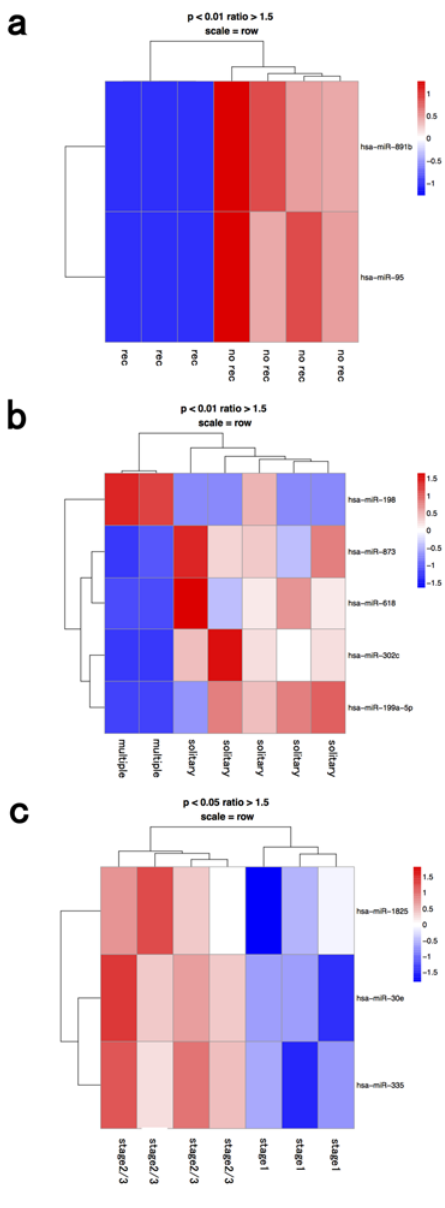
Figure 1. Hierarchical clustering analysis of microRNAs of whole bone marrow cells in seven patients with hepatocellular carcinoma. Heat map of the miRNA profile in bone marrow cells from hepatocellular carcinoma patients with ( a ) recurrence ( n = 3) and no recurrence ( n = 4); ( b ) solitary ( n = 5) and multiple tumors ( n = 2); ( c ) stage 1 ( n = 3) and ≥ stage 2 ( n = 4). Cluster analysis showed two, five, and three miRNAs that were significantly differentially expressed between the two groups with a >1.50-fold change, respectively. Colors range from blue to red, corresponding to low to high expression, respectively. p values <0.01 or <0.05, unpaired t test. rec: